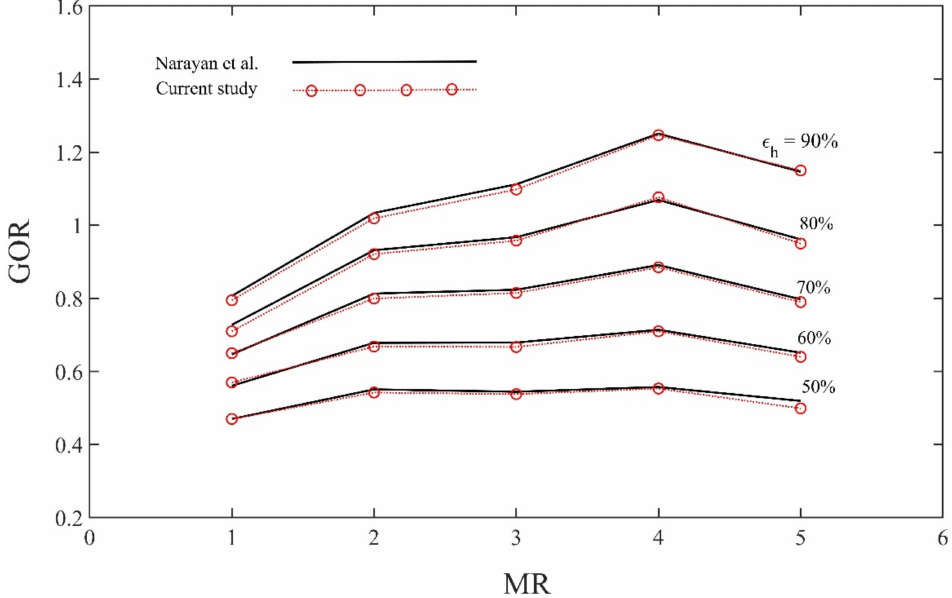
Figure 13. Comparison of current HDH model with Narayan et al.